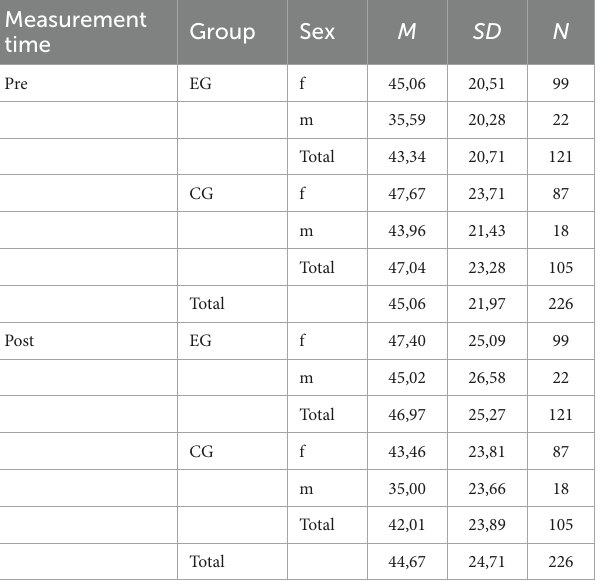
TABLE 1 Descriptive statistics of the mixed ANOVA. Measurement